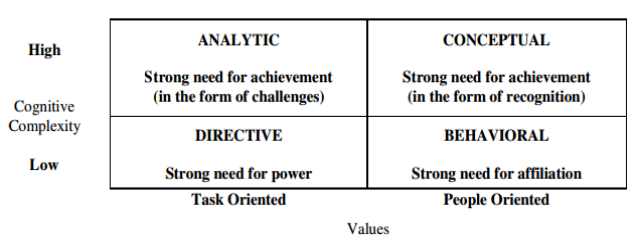
Figure 4: Decision-making styles